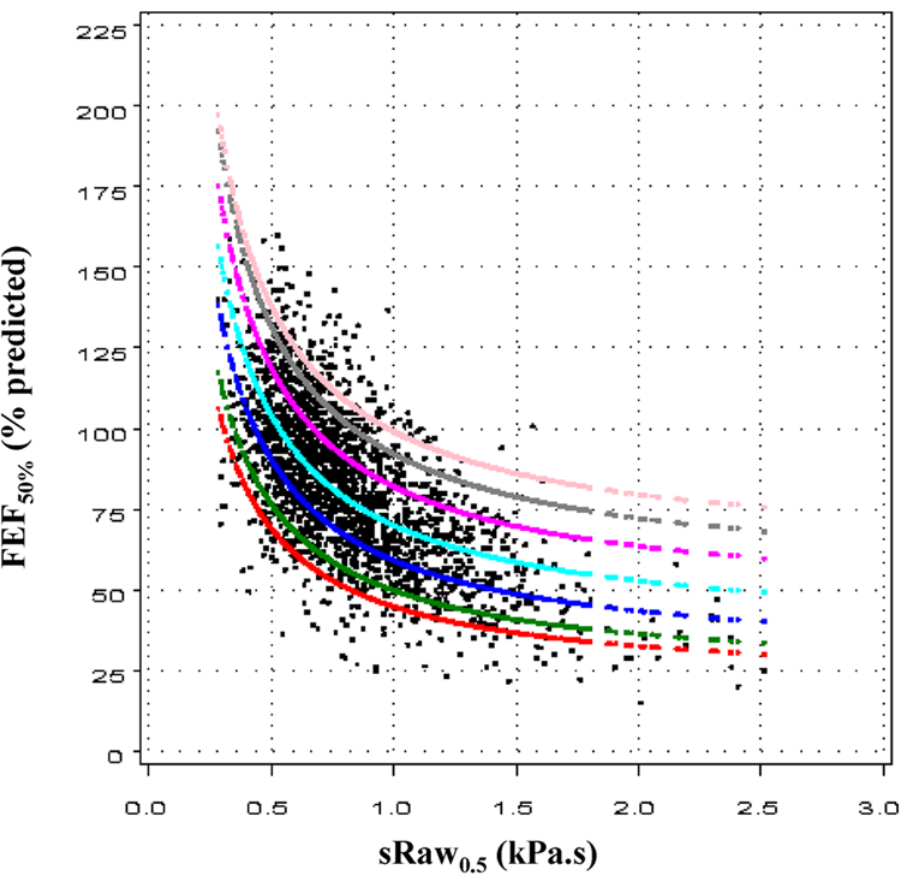
Figure 2. Quantile regression models in which a specified conditional quantile (or percentile) of FEF 50% was expressed as a linear function of the inverse of sRaw 0.5 . The 5% (red line), 10% (green line), 25% (dark blue line), 50% (blue), 75% (dark pink line), 90% (grey line) and 95% (pink line) percentiles are shown. When using quantile regression by examining multiple percentiles rather than only the mean, one can examine how the entire distribution of FEF 50% changes with sRaw 0.5 .